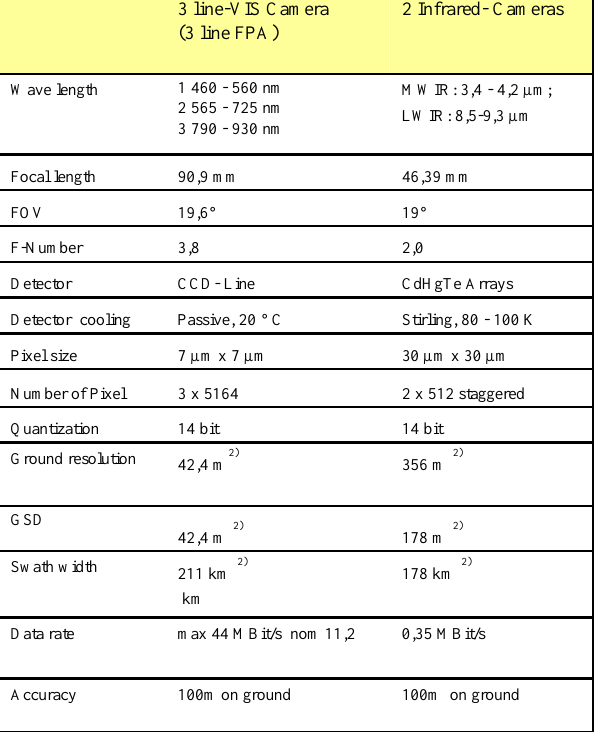
Table 1. Main FireBird camera